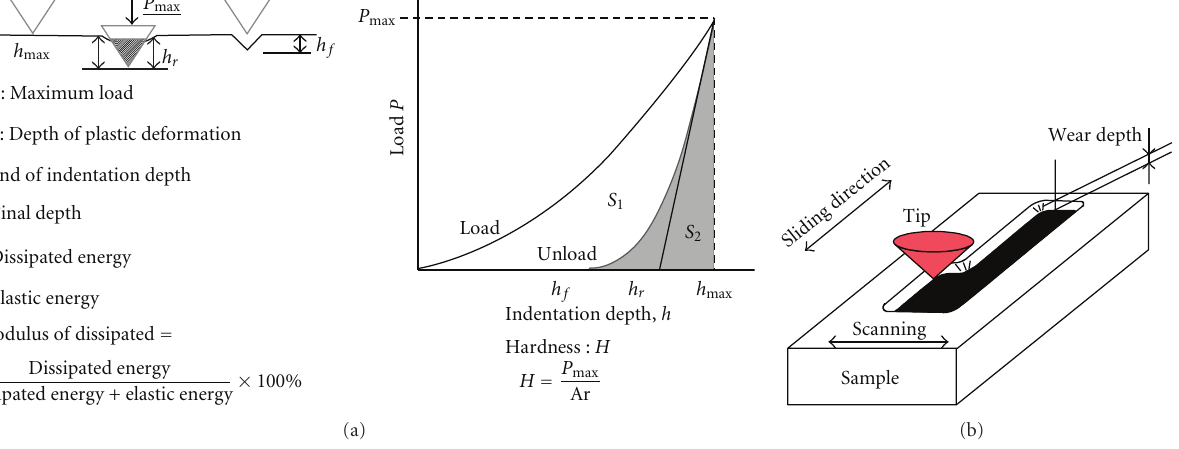
Figure 2: Evaluation methods in (a) nanoindentation test and (b) nanowear